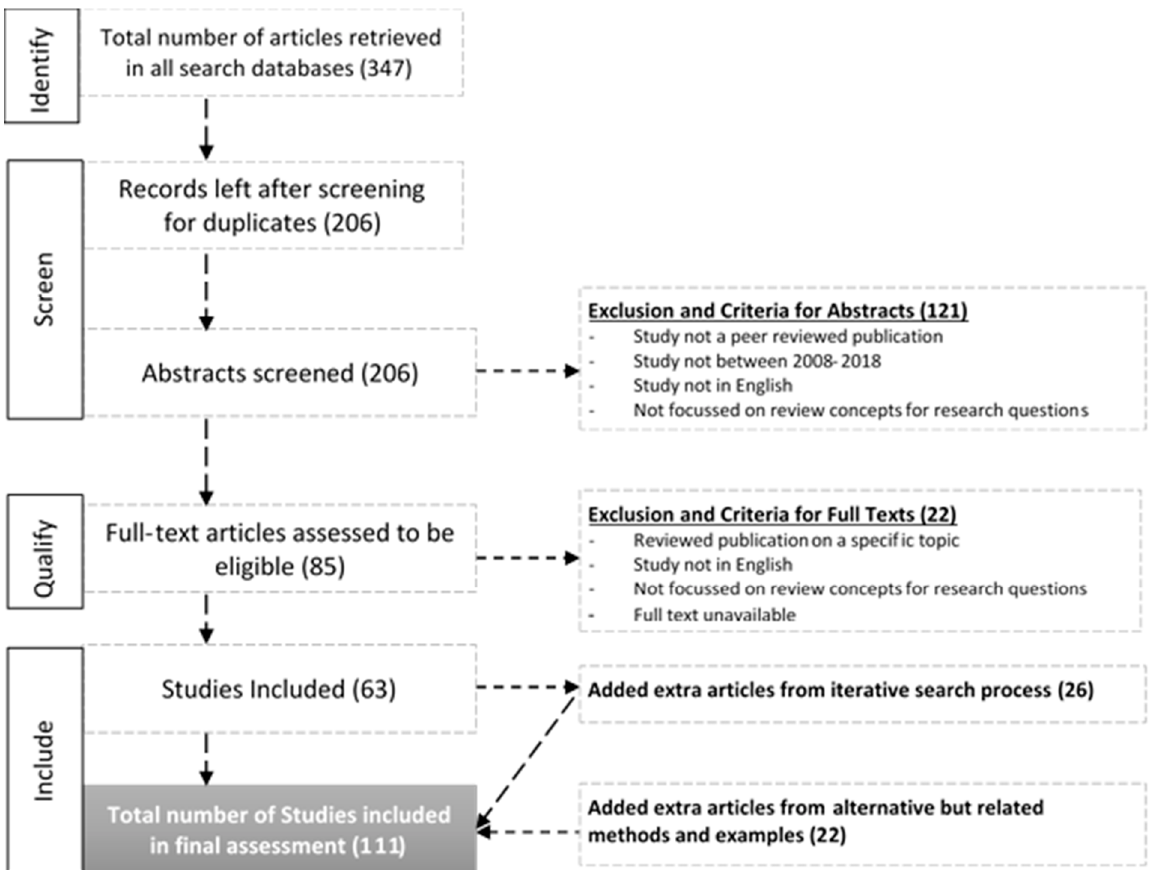
Figure 1. The research approach to include and exclude relevant articles.